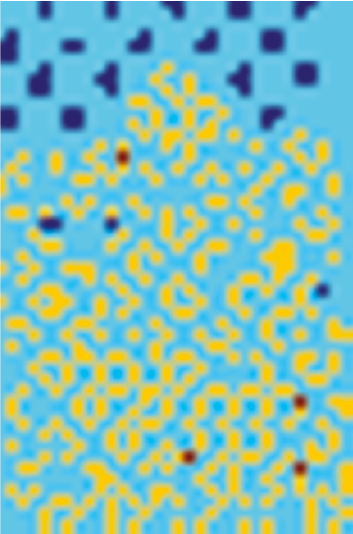
Figure 8: Map of for di ff erent k values: k = 0 in navy blue, k = 1 in Cambridge blue, k = 2 in yellow and k = 3 in